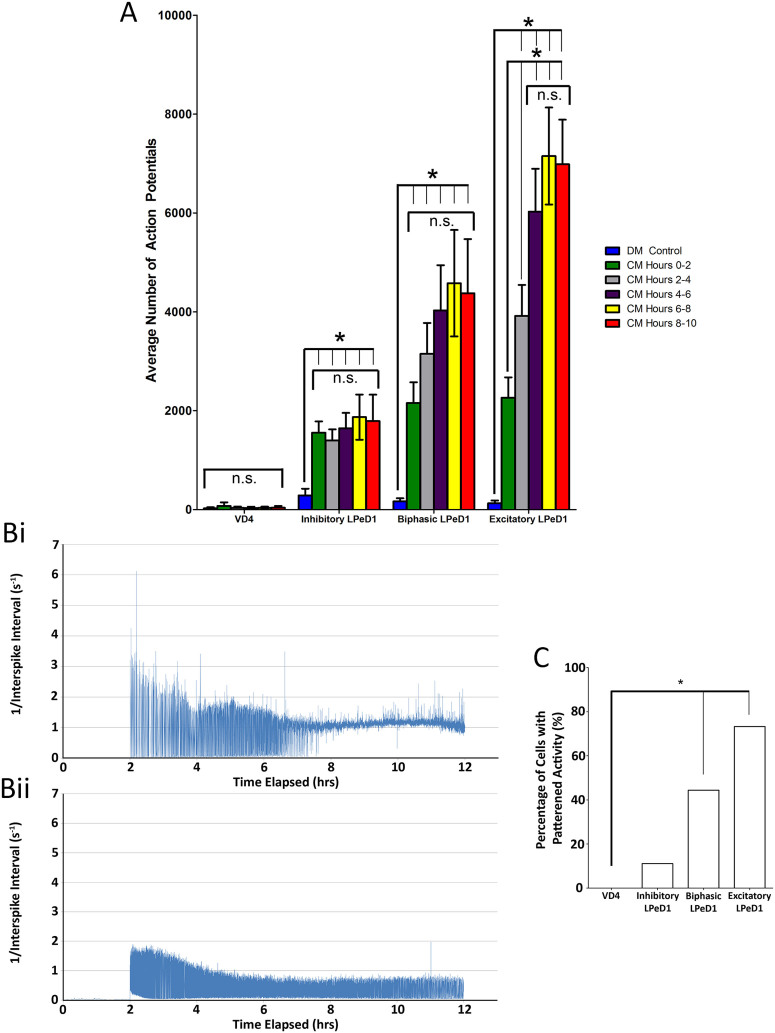
Neuronal activity in inhibitory, biphasic and excitatory LPeD1 cells and the corresponding activity pattern expressed as 1/interspike interval.(A) Neuronal electrical activity observed over a 12 hour period of VD4 and LPeD1 cells that responded to acetylcholine with inhibitory, biphasic, and excitatory responses. VD4 and LPeD1 neurons were cultured overnight on MEAs in DM and control recordings were obtained in DM followed by CM exposure. The responses of LPeD1 cells to ACh were tested 10 hours following CM addition. Each measure of activity represents the average number of action potentials recorded per a 2 hour period. Note the different responses of LPeD1 cells exposed to CM among the various different LPeD1 phenotypes. Next, to examine activity over an extended period of time, the interspike interval (ISI; time elapsed between two action potentials) was calculated and the inverse of the ISI was taken to give a measure of frequency. Using this protocol, we examined the firing pattern and found that a characteristic of (Bi) excitatory LPeD1 neurons was a progression of activity towards a tightly regulated firing rate of approximately 1 Hz, while the firing frequency of (Bii) inhibitory cells did not undergo this change in pattern and neurons continued to fire at a highly variable rate. After fingerprinting this pattern, we correlated the patterned activity with receptor expression using blinded scoring. It can be seen that (C) excitatory receptor expressions is significantly correlated with patterned activity. Significant differences are denoted with an asterisk (*) and significance is assumed if p < 0.05. Non-significantly different groups were designated with “n.s.”.